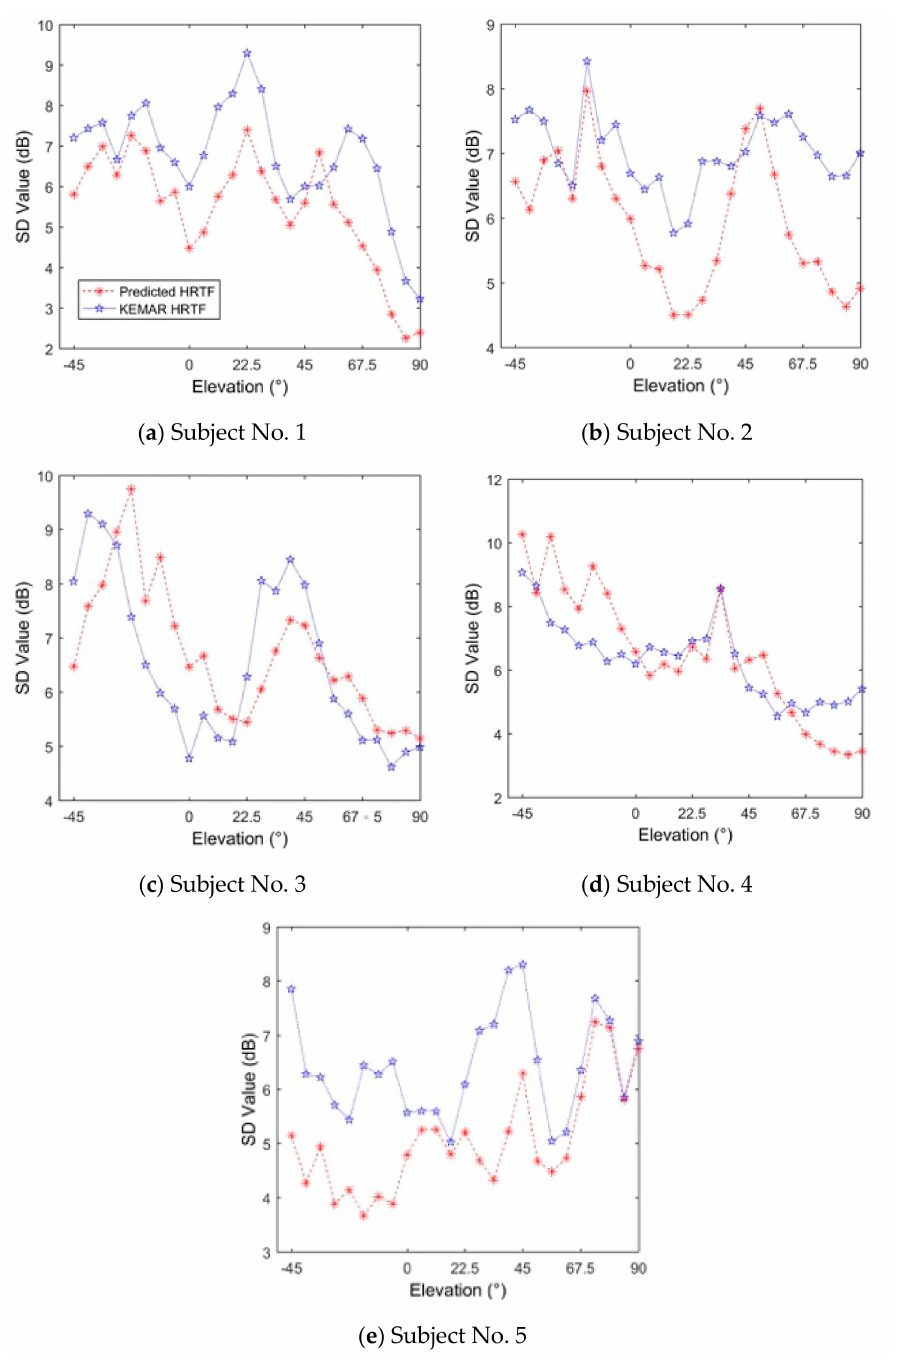
Figure 7. Spectral distortion (SD) of the validation group at 25 elevations in the median plane. The values are averaged across left and right